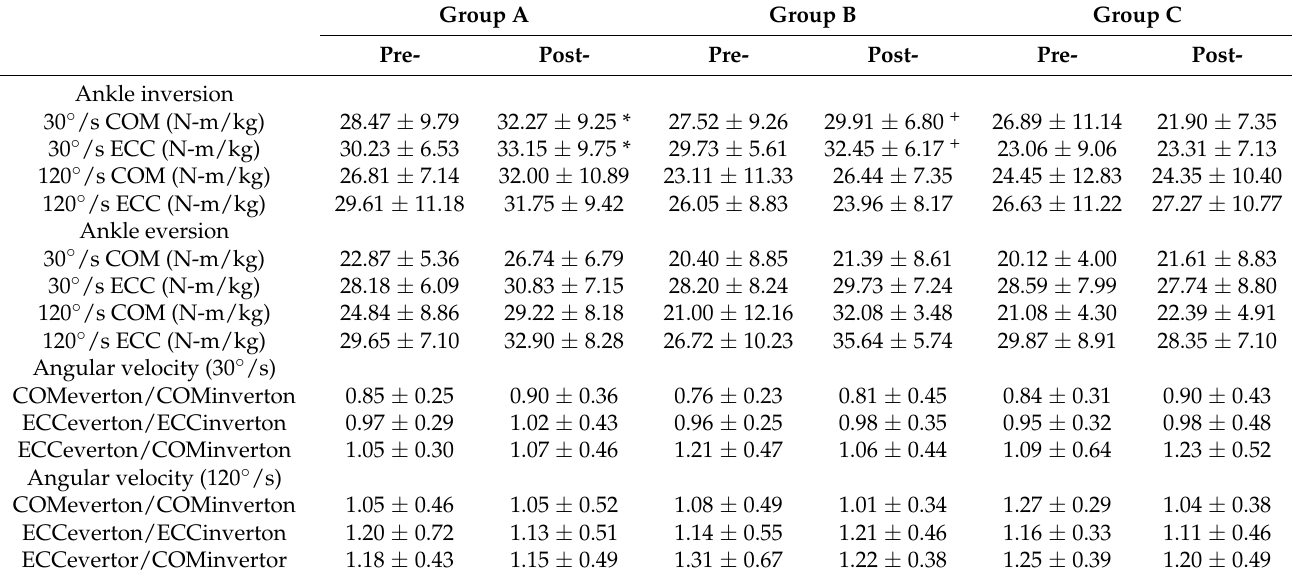
Table 6. Results of isokinetic strength test in three groups. Group A Group